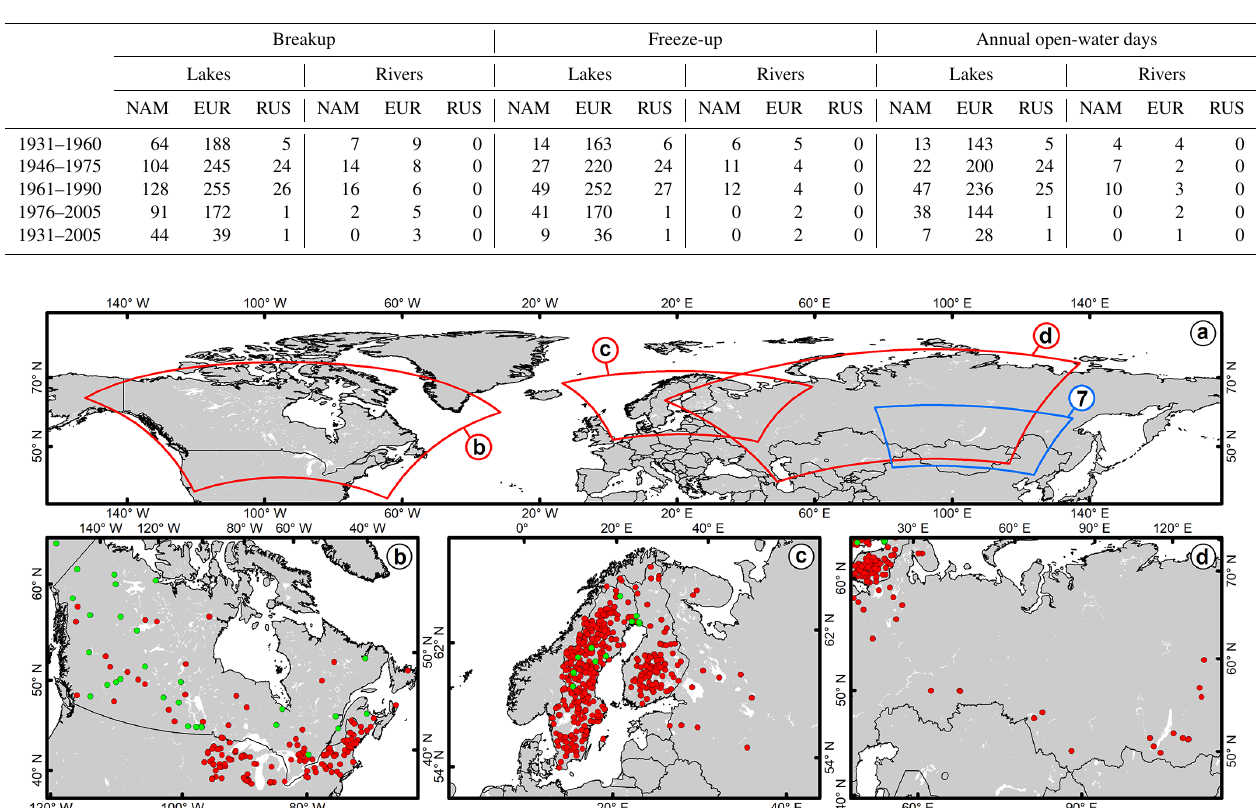
Magnuson (2014), a range of running means were applied, with an 11-year window shown to be the most useful for the 75-year time